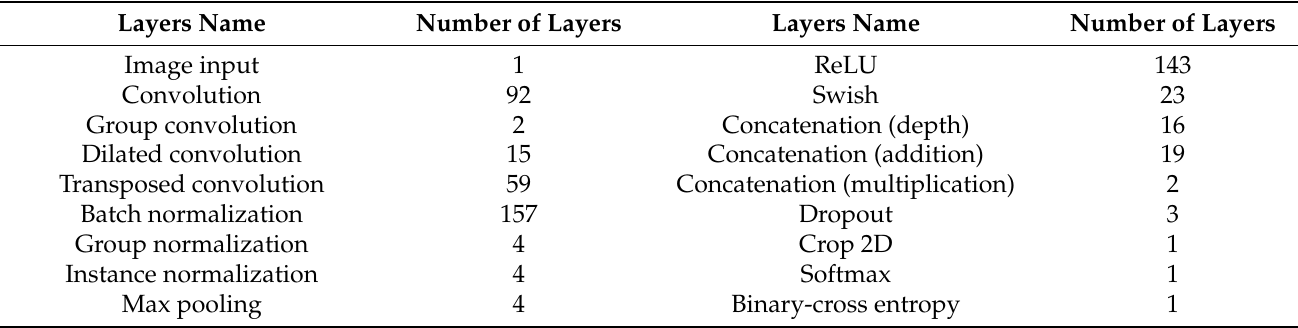
Table 4. Characteristics of the ThelR547v1 network architecture.